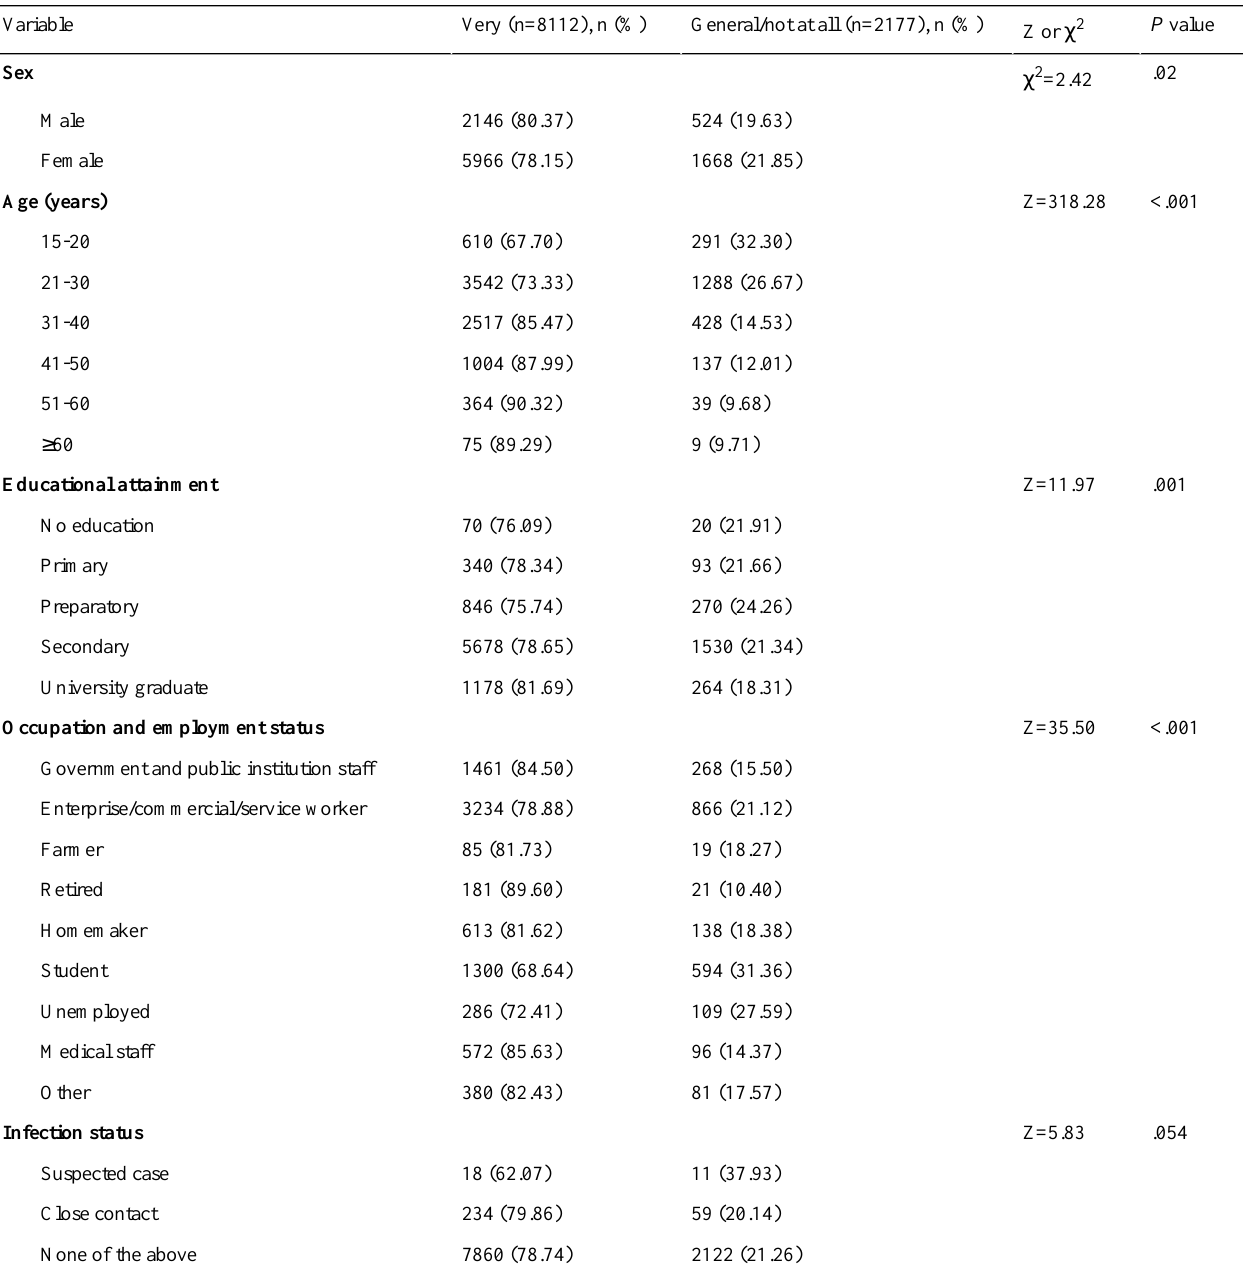
Table 3. Concerns about COVID-19 according to participants’characteristics.